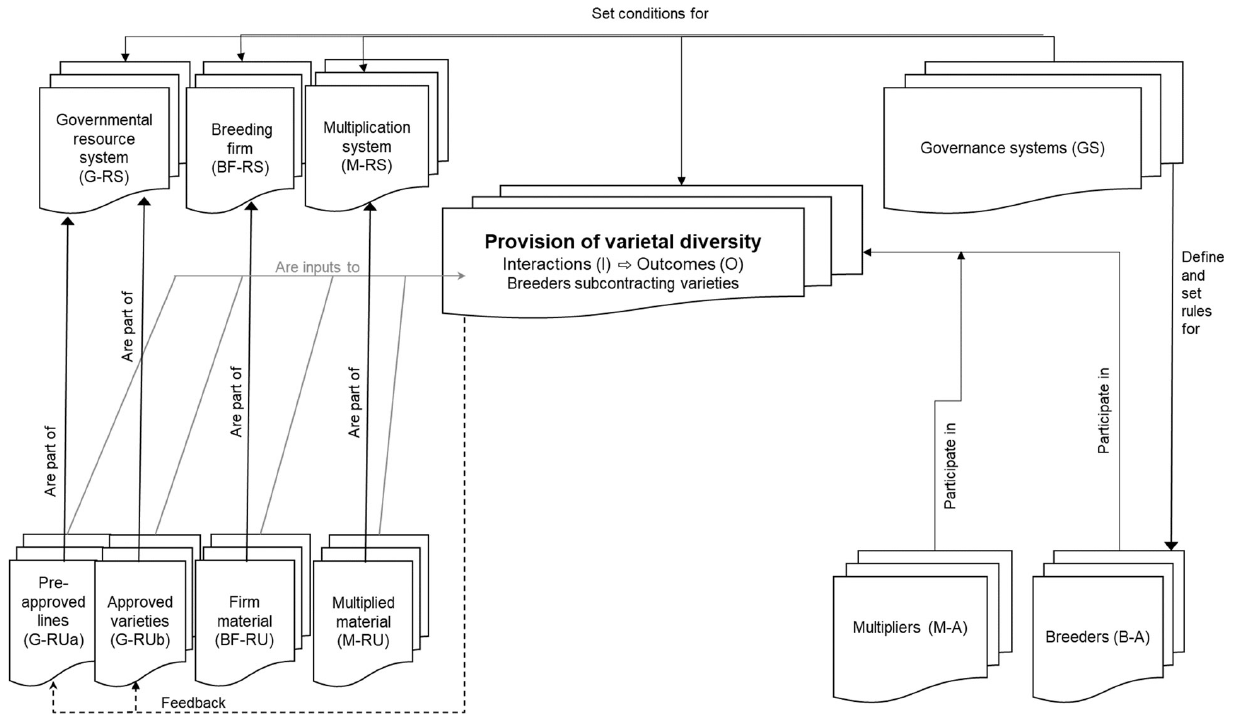
Fig. 3 . First-tier social-ecological system framework components for provisioning varietal